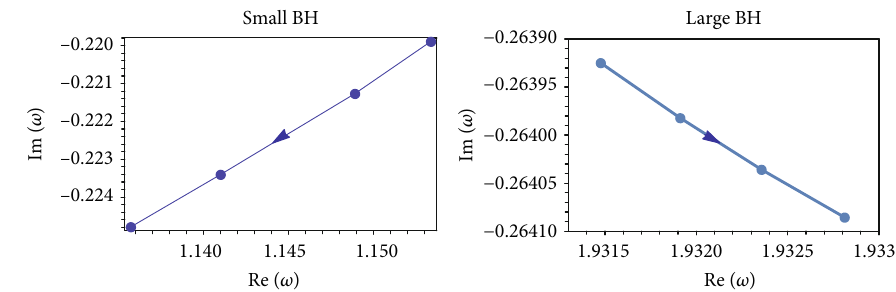
Figure 6: The real and imaginary parts of frequencies for large and small black holes with ω